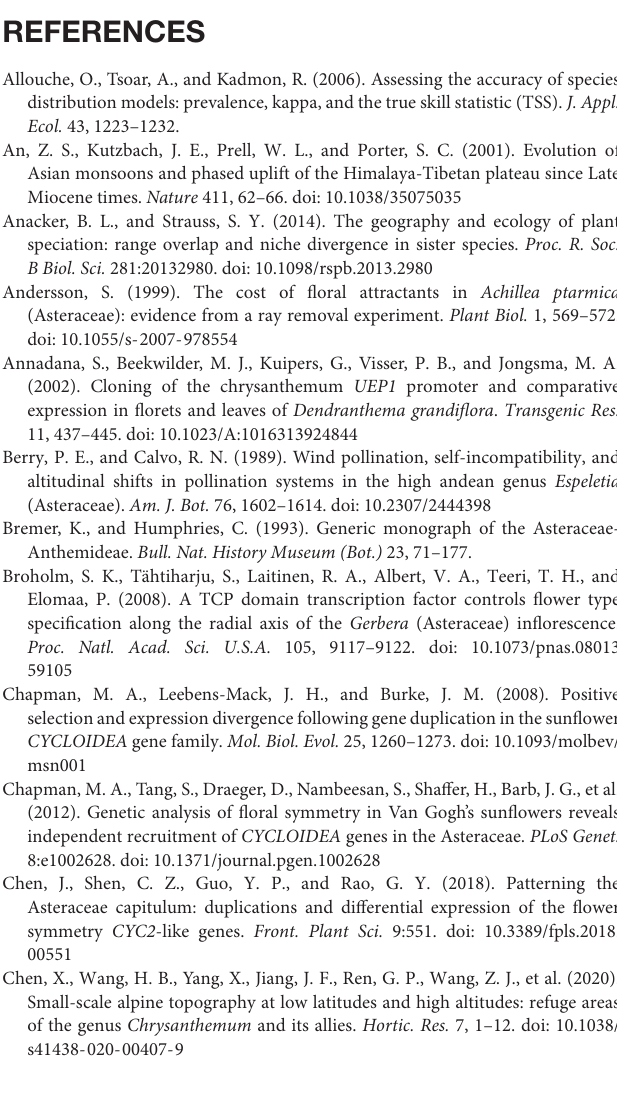
Supplementary Figure 2 | Historical biogeographical analyses of subtribe Artemisiinae. Supplementary Figure 3 | Time frame comparison among four different calibration settings. Supplementary Figure 4 | Principal component analysis (PCA) of environmental factors of the Chrysanthemum -group.